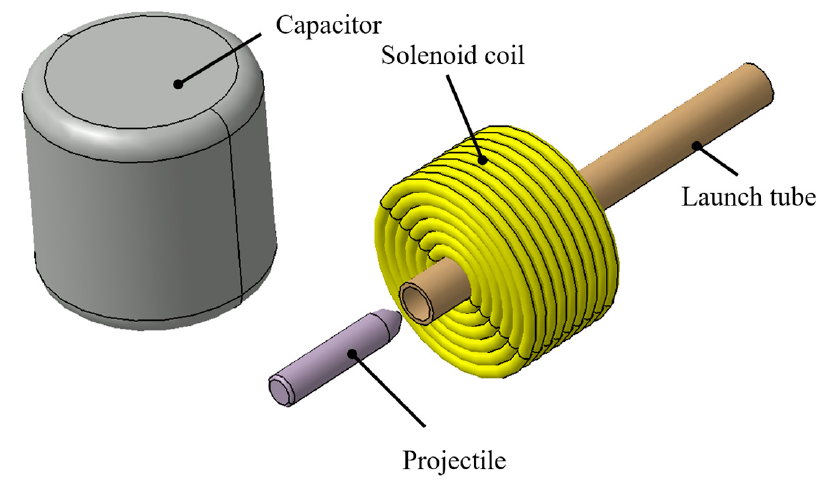
Figure 2. The schematic diagram of coil gun.